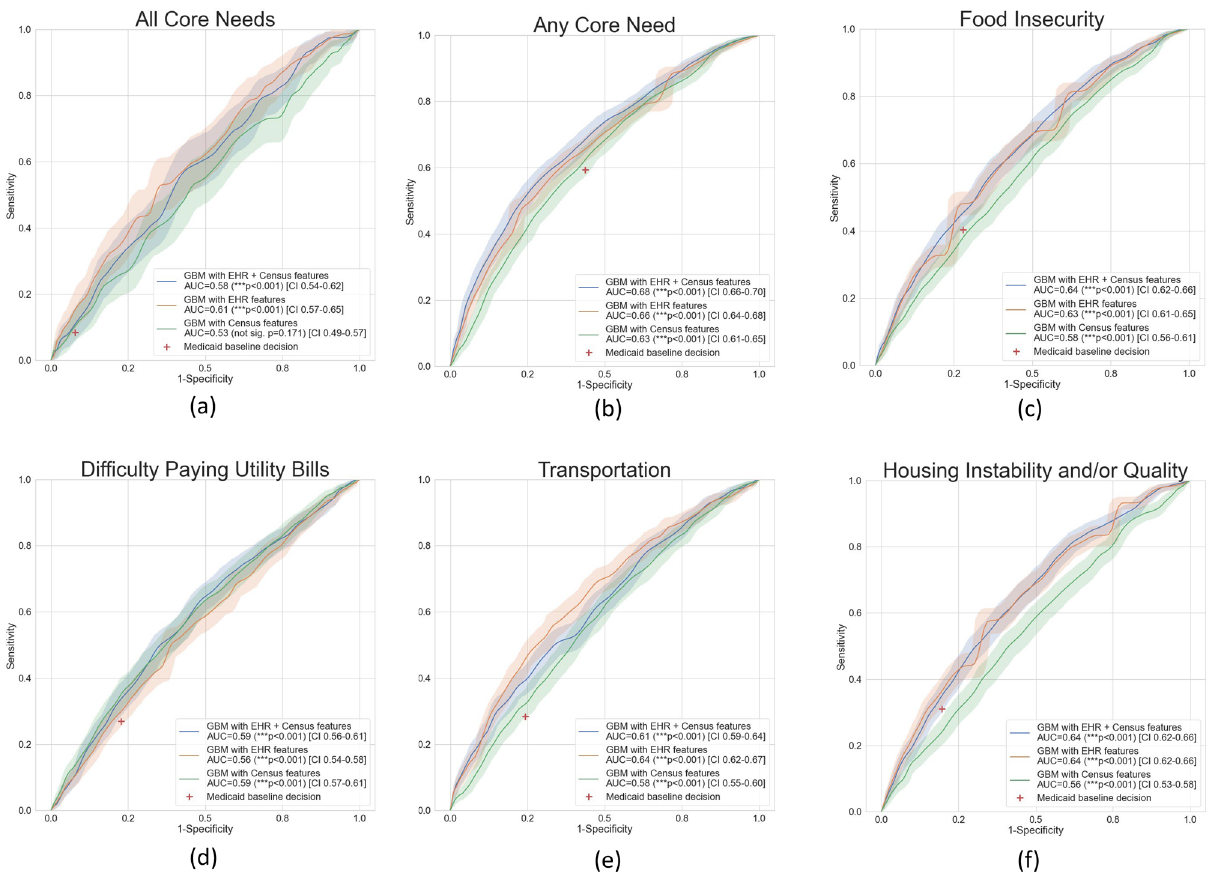
Figure 3. Machine learning model predictive value by HRSN